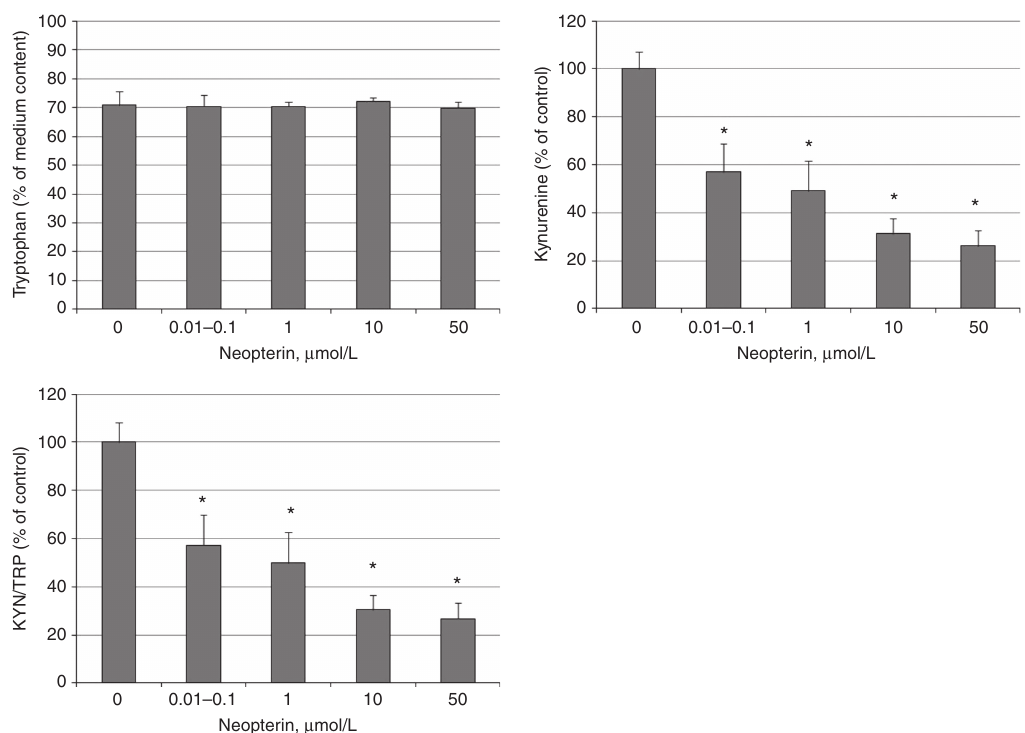
Figure 1 Concentrations of tryptophan (upper left), kynurenine (upper right), and the kynurenine-to-tryptophan ratio (KYN/TRP) in the supernatants collected from unstimulated peripheral blood mononuclear cells after exposure to increasing concentrations of neopterin for 48 h. Columns are representative for three independent experiments with cells obtained from three different donors and run in duplicates. Results are expressed as % of baseline (or as % of initial medium content for tryptophan), and columns show mean ± standard error of the mean; *p <